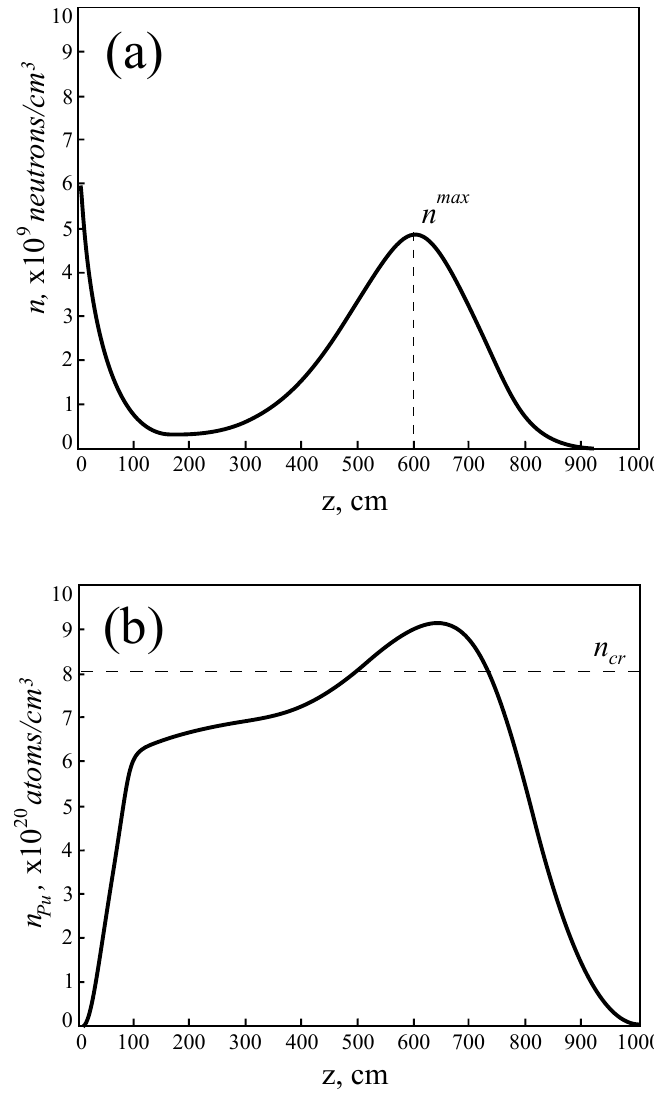
Figure 6. The concentration distribution of neutrons at the velocity of wave propagation u 2 . 77 cm/day ( a ) and 239 P u at ˜ n simul ≈ a cylinder over the period t = 217 days